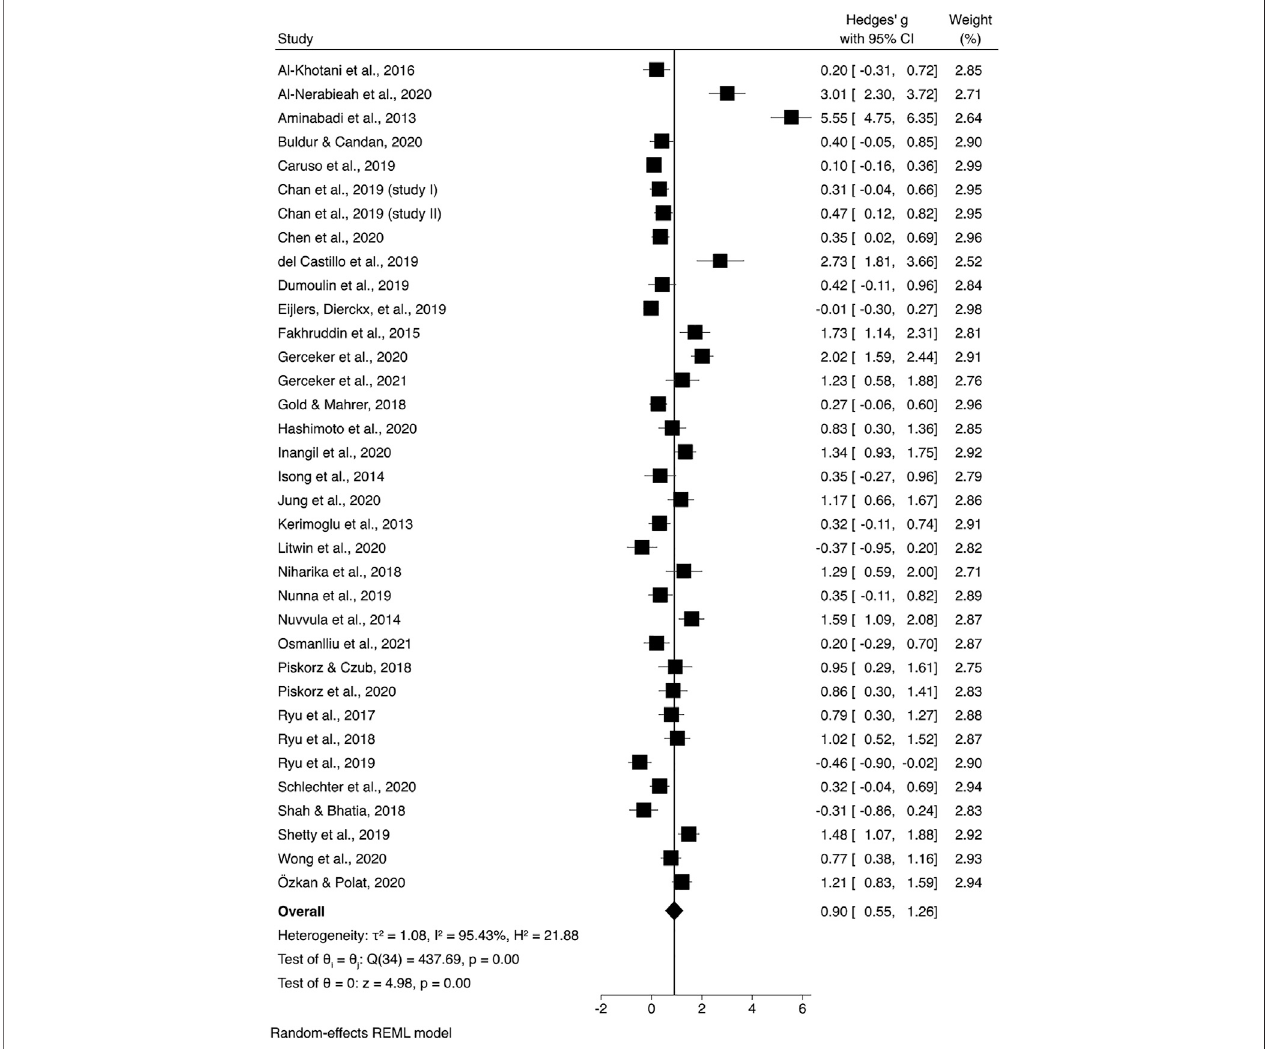
FIGURE 7 | Forest plot of individual and combined results from studies reporting anxiety outcomes.